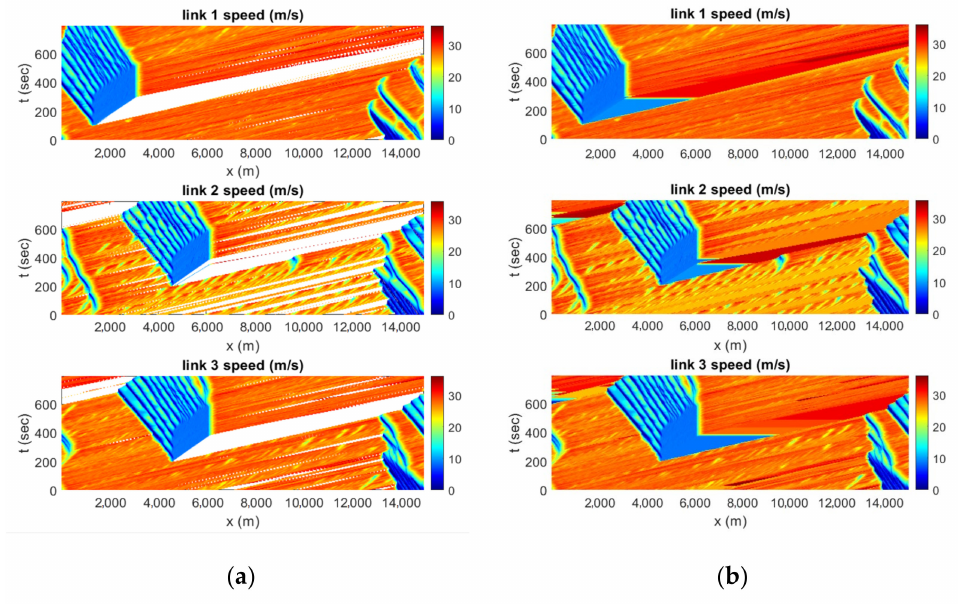
Figure 4. ( a ) Speed contour plot showing cells where no vehicle detected; ( b ) speed contour where missing cells filled with the speed of neighboring cells.